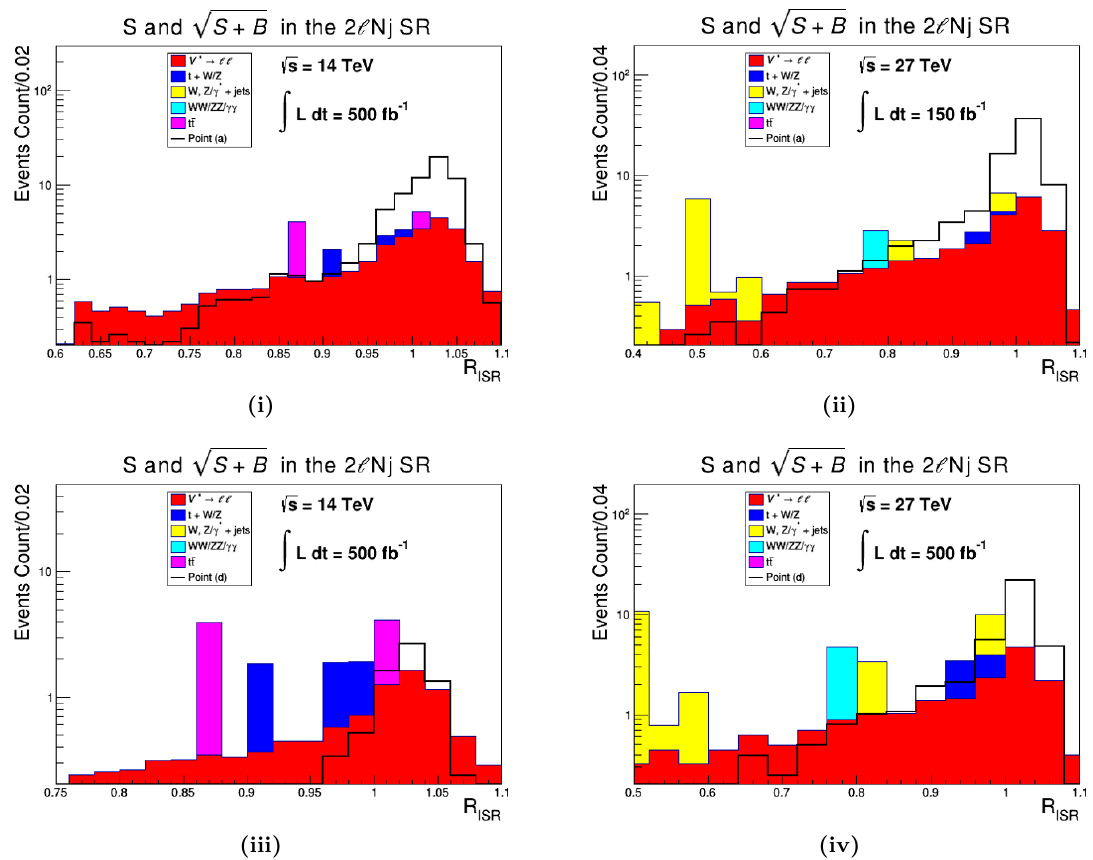
Figure 7. Distributions in R ISR at 14 TeV and 27 TeV for benchmarks (a) and (d) after applying all cuts in table 6 except the ones on R ISR . Point (a) can be discovered at both HL-LHC and HE-LHC while point (d) is only visible at